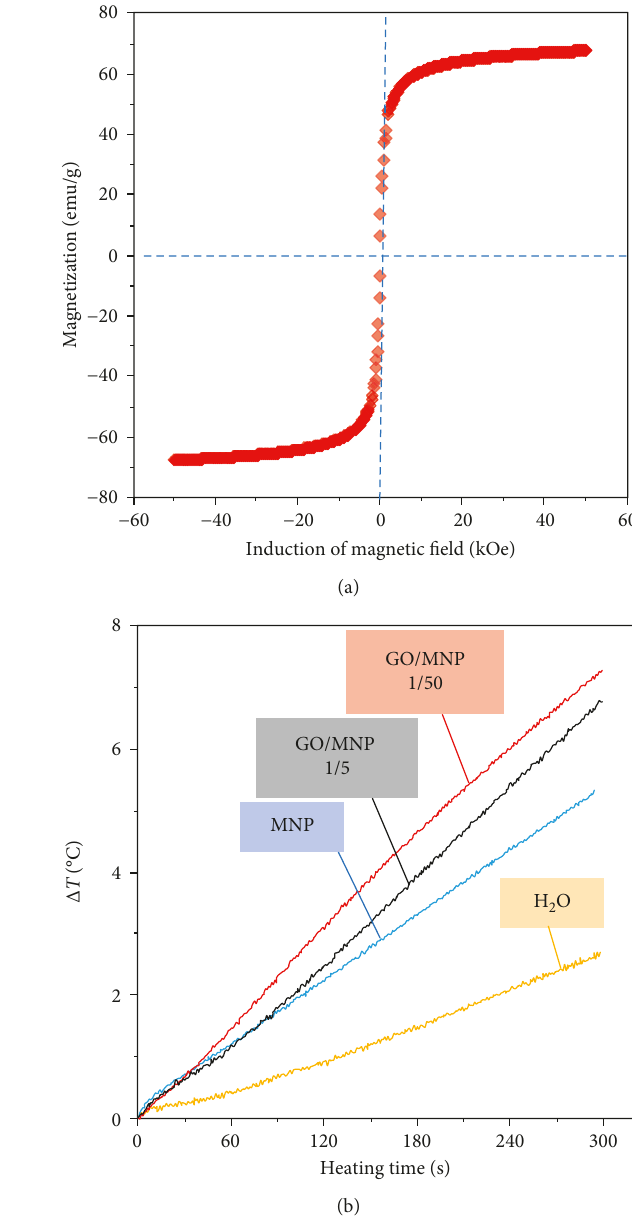
Figure 9: Magnetization curve of the MNPs (a) and heating curves (b) of nanocomposite dispersions of 5g/L MNP content at two different GO/MNP ratios as compared to those of pure water and the bare MNP suspension of the same